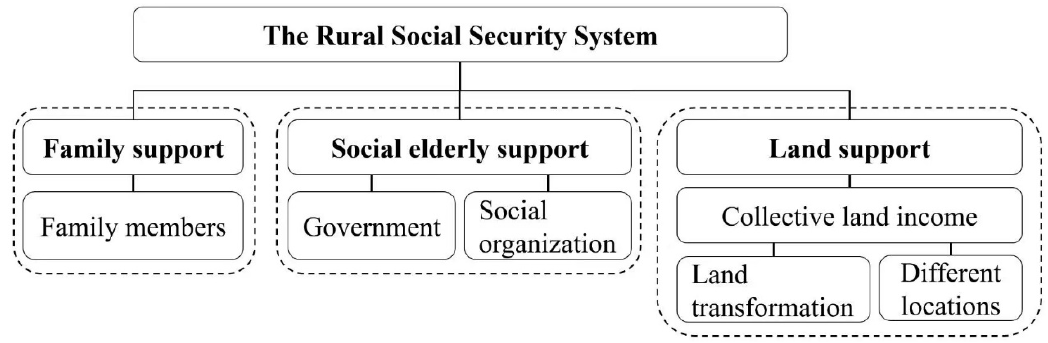
Figure 1. Conceptual Framework.